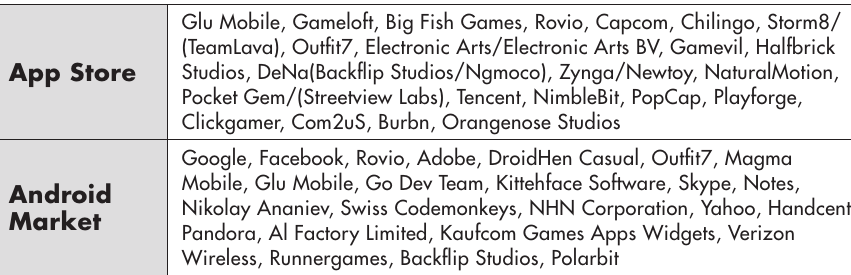
Table 6 Key 25 app developers for Apple (iOS ） and Google